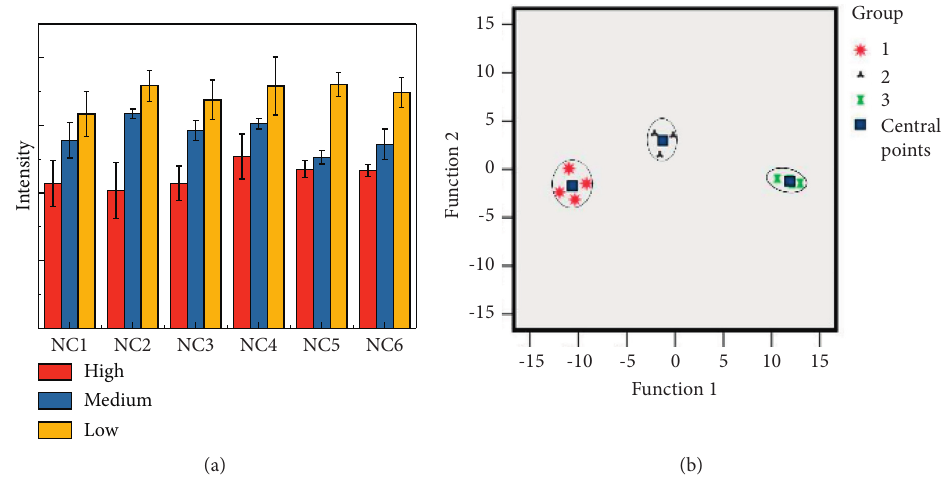
Figure 4: Array-based sensing of artificial bovine serum samples with different CA125 levels. (a) Fluorescence emission intensity (610 nm) patterns of the 3 types of samples (low, medium, and high level of CA125) on the AuNCs array as an average of 4 parallel measurements. (b) LDA shows the excellent separation of the samples with different levels of